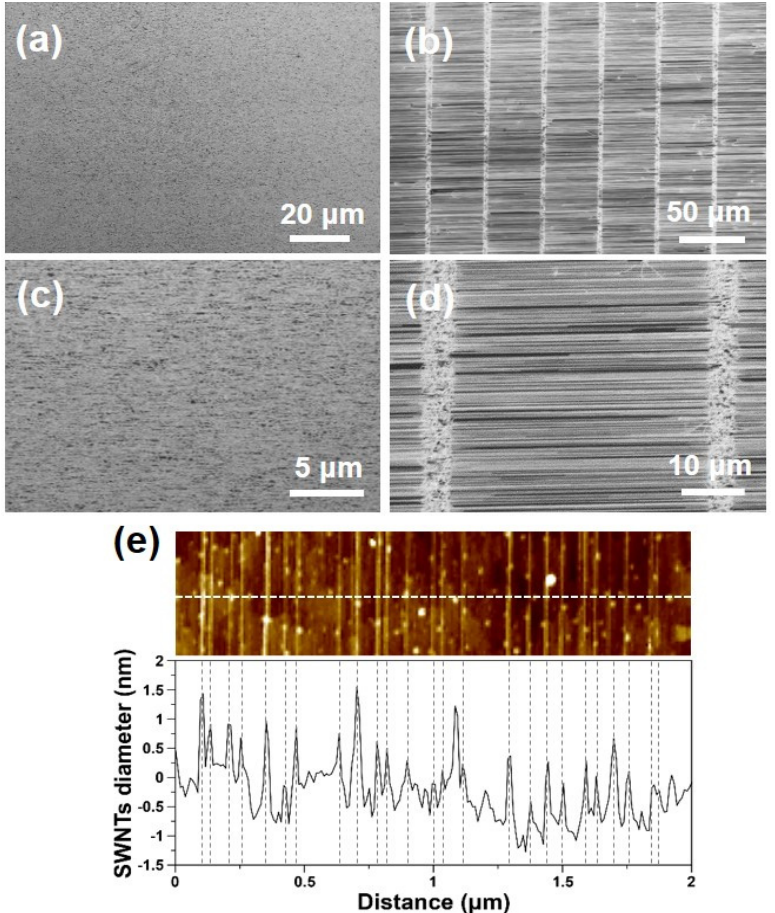
Figure 8. SEM images of SWNTs taken at the maximum-synthesis-yield region of plain ( a , c ) and line-patterned ( b , d ) ST-cut quartz wafers. ( e ) AFM topographic image and corresponding height profile obtained from ( d ). The sample was grown at 900 °C with H 2 :CH 4 = 25:225 sccm.